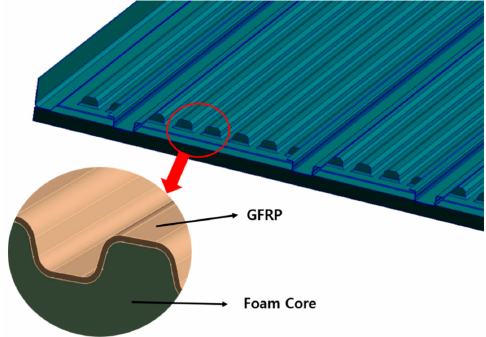
Figure 2. Detailed structural configuration of floor.